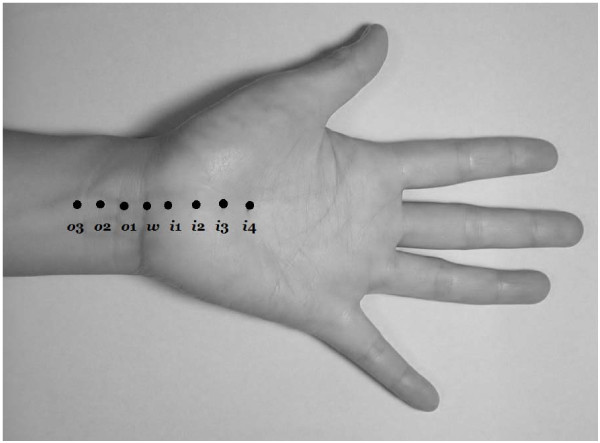
The 8 points (i4, i3, i2, i1, w, o1, o2, and o3) for recording in both the “inching test” and ultrasonography.i4, i3, i2, i1 represent levels at 4, 3, 2, and 1 cm distal to the wrist crease in the inlet of the carpal tunnel; w represents the level of the wrist crease and o1, o2, and o3 represent levels at 1, 2, and 3 cm proximal to the wrist crease in the outlet of the carpal tunnel.